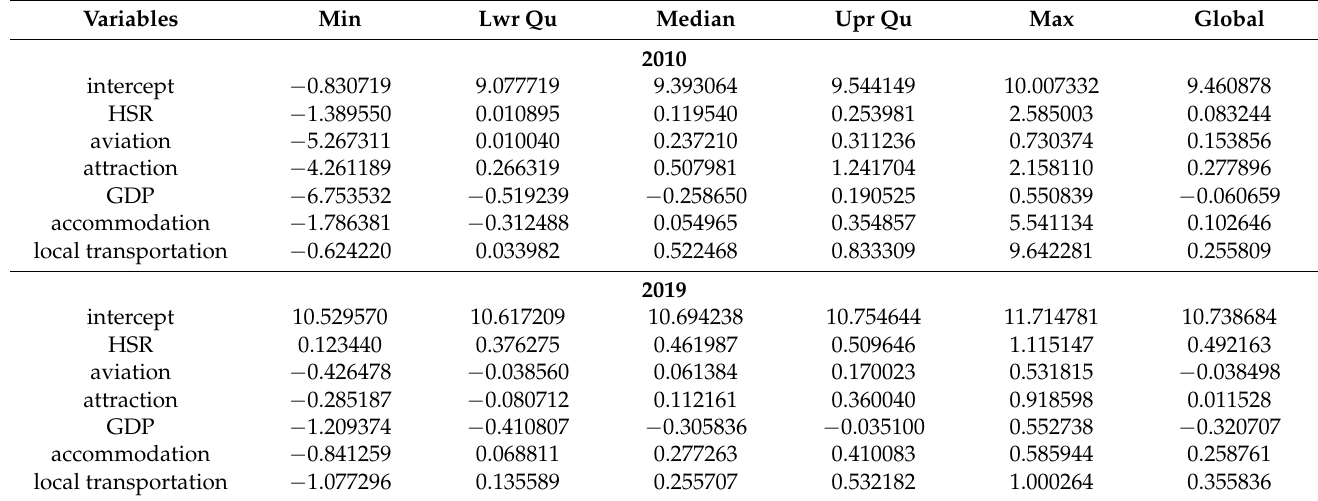
Table 2. GWPR Results for the year